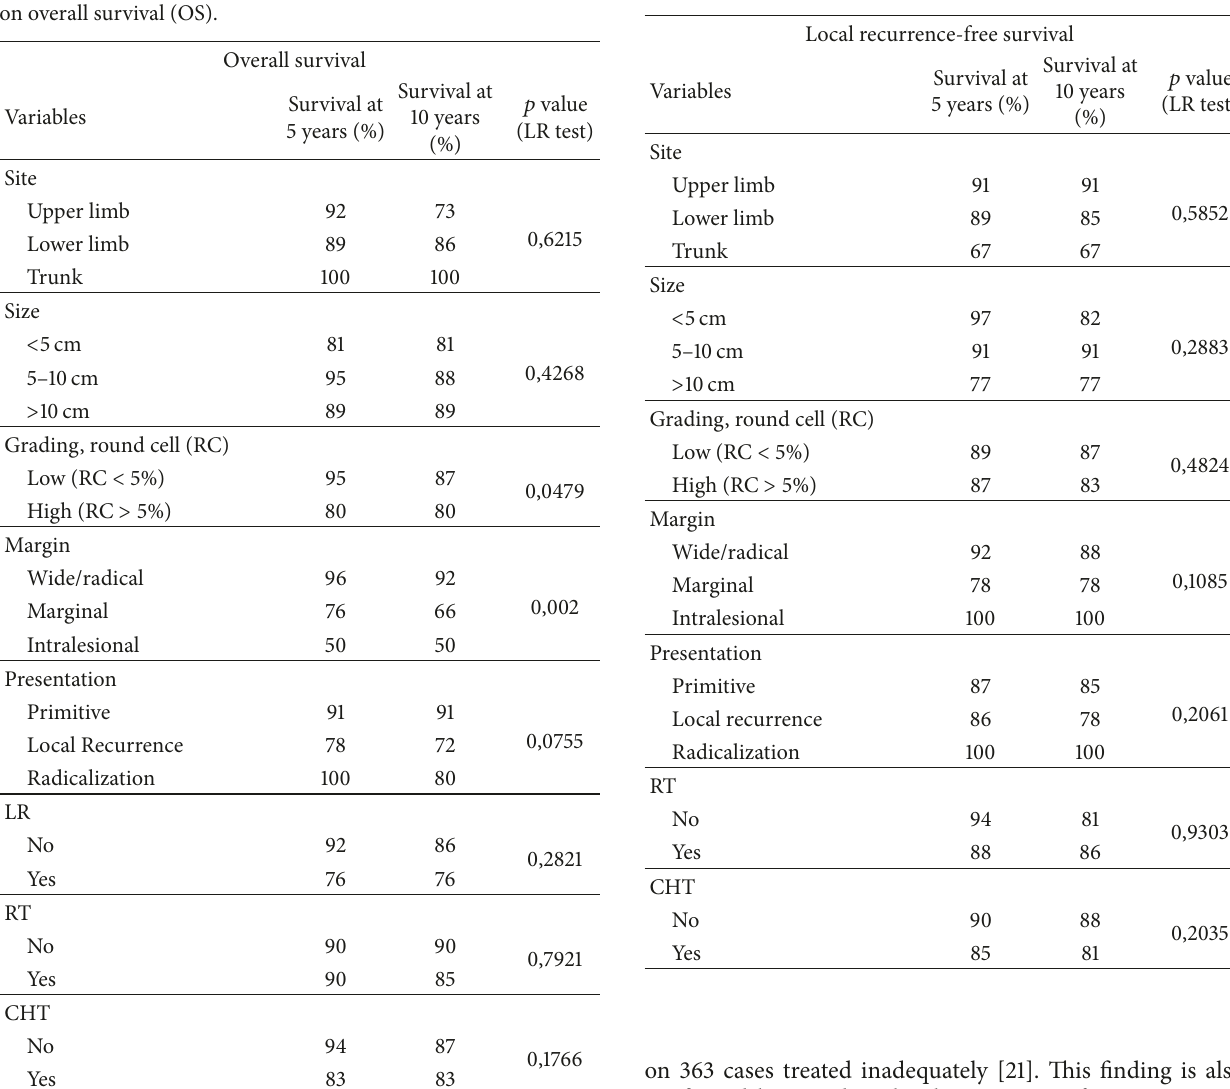
Table 4: Statistical analysis shows no significant risk factors for the local recurrence-free survival